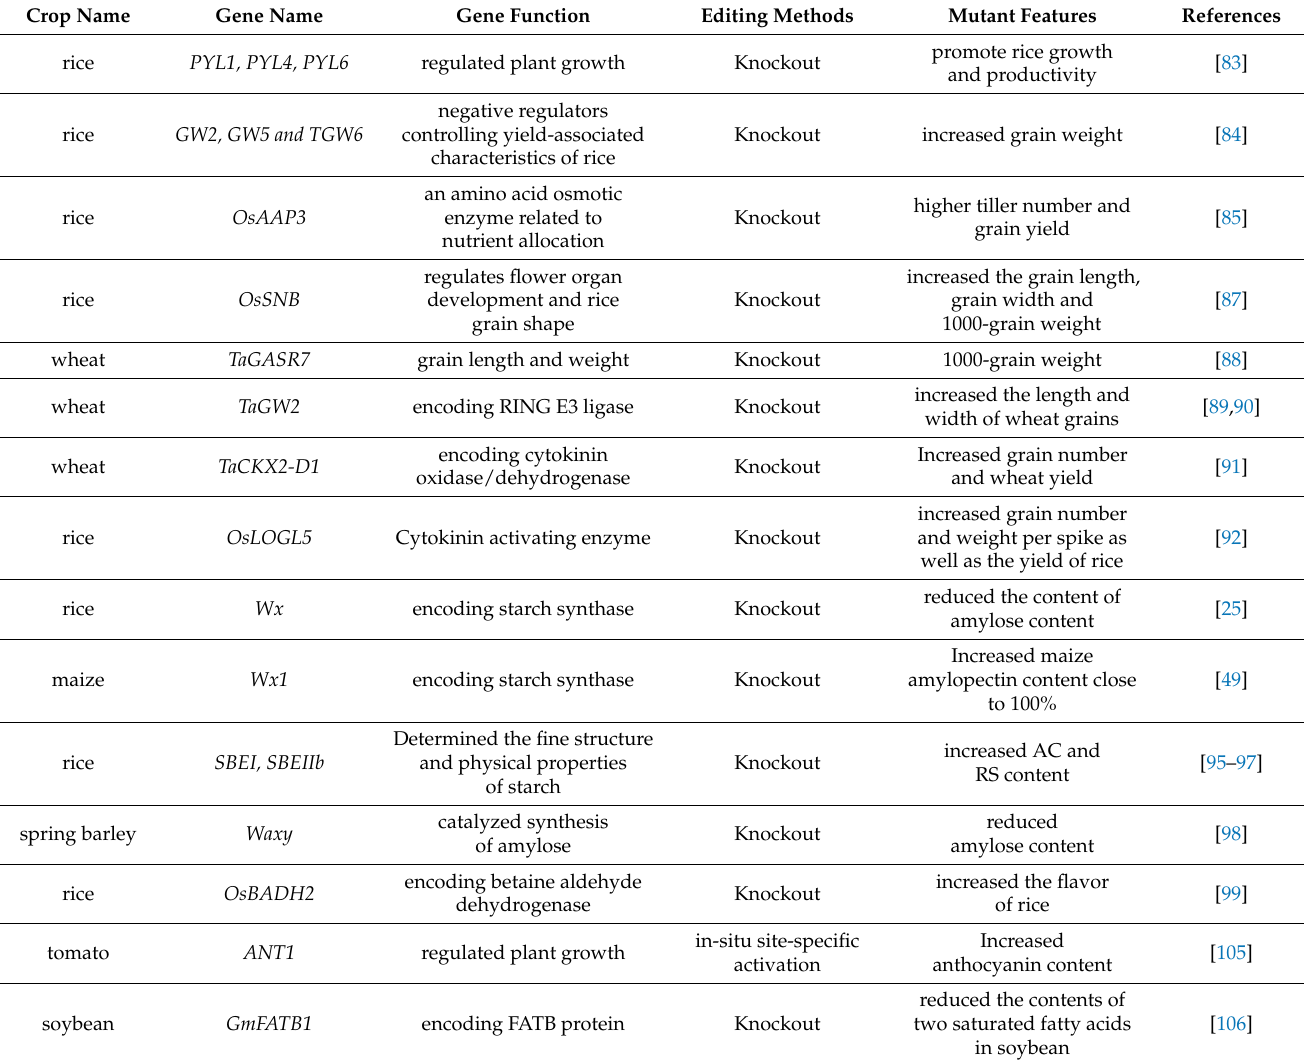
Table 2. Examples of genes from various crops that have been modified by the CRISPR/Cas9 system to increase crop yield and